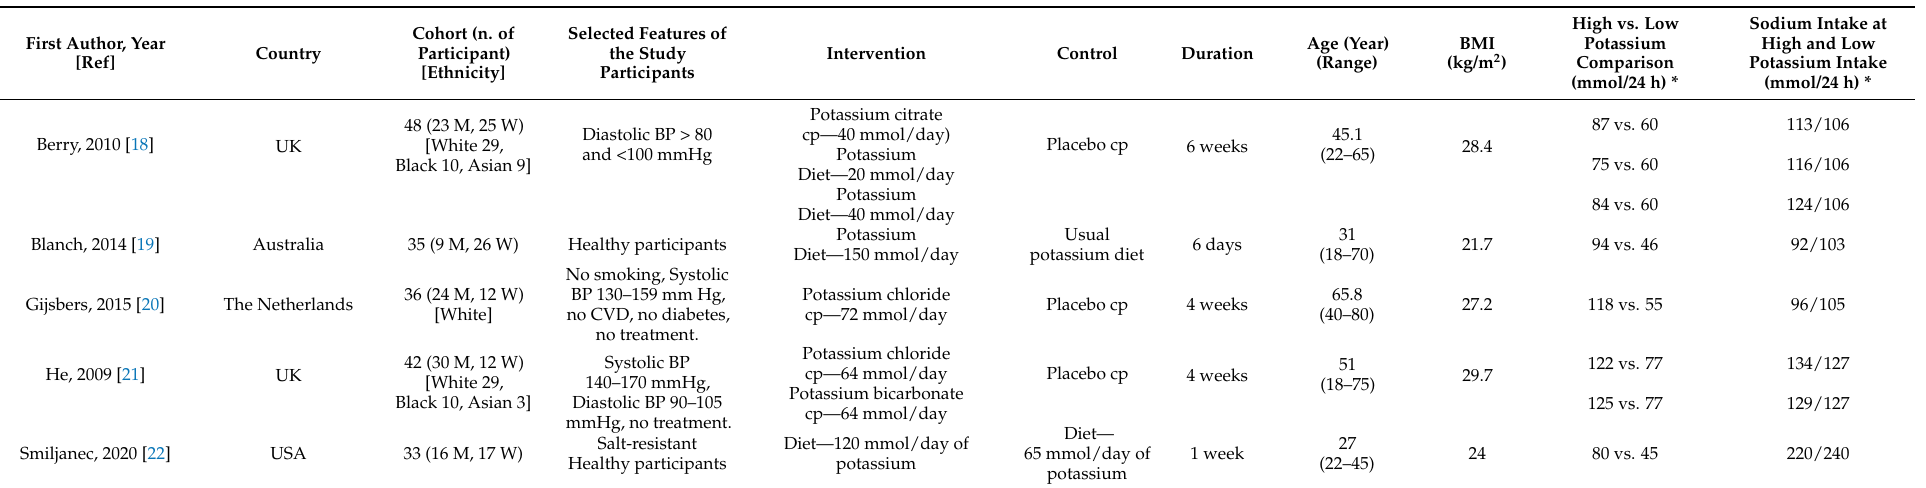
Table 1. Characteristics of the studies included in the